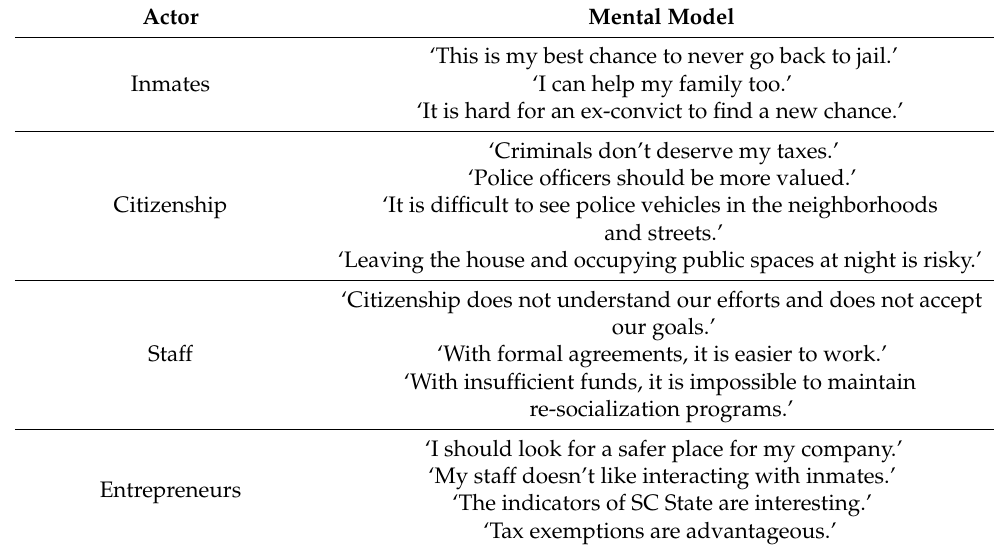
Table 7. Actors and mental